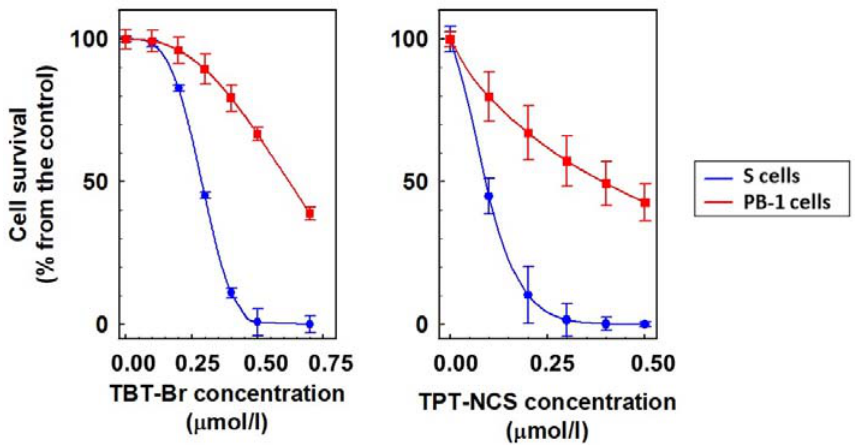
Figure 2. The cell death effects of TBT-Br and TPT-NCS on S and PB-1 cells. The cells’ prior measurements were 48 h cultivated in cultivation medium in the absence or presence of the respective triorganotin derivatives at different concentrations. The data were fitted by nonlinear regression according to Equation (1) using SigmaPlot 8.0 software (Systat Software, Inc., San Jose, CA, USA) and represent the means ± S.E.M. from six independent measurements. IC 50 values of both triorganotin derivatives for induction of S cell death are summarized in Table 2. Values IC 50 equal to 0.62 ± 0.04 µM and 0.39 ± 0.03 µM were calculated for TBT-Br and TPT-NCS induced PB-1 cell death and differ from corresponding IC 50 values obtained for S cells on the levels p < 0.02.